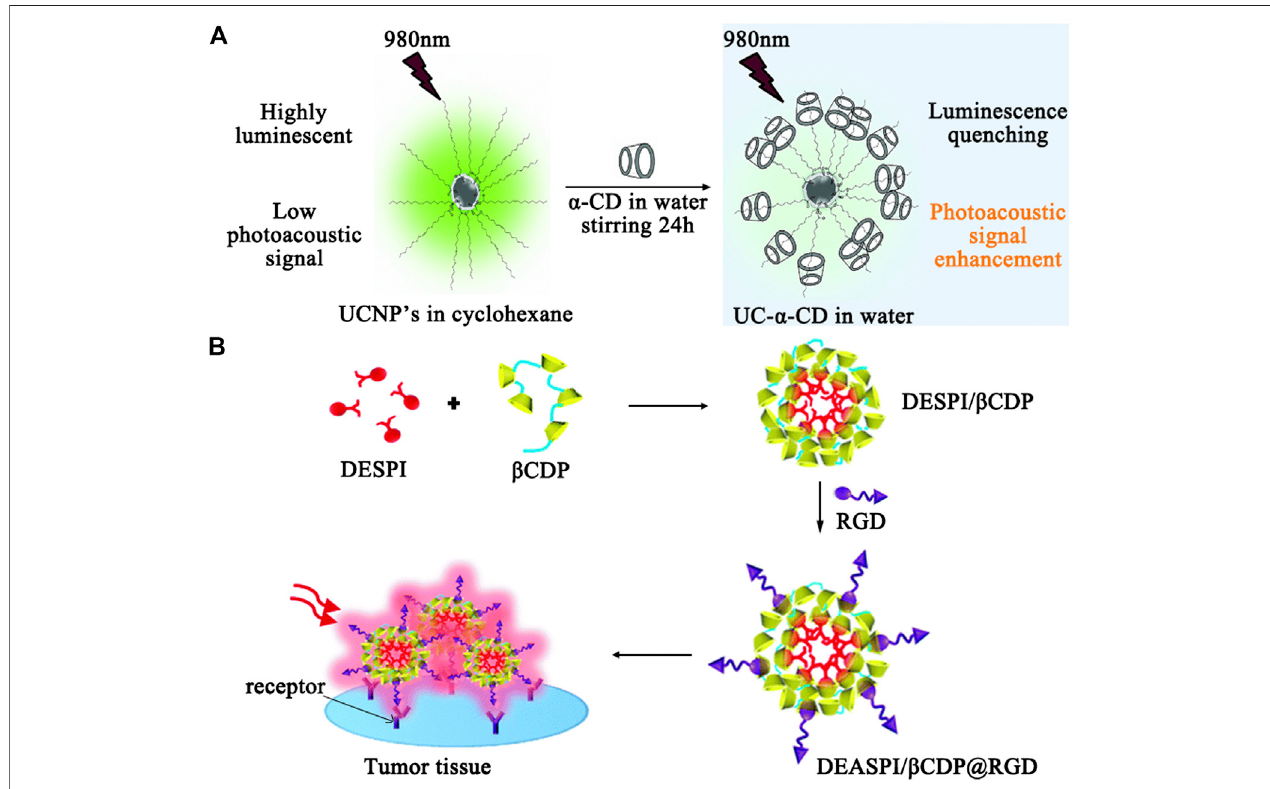
FIGURE 4 | (A) Illustration of luminescence quenching effect and subsequent photoacoustic signal enhancement from UC- α -CD in water. (B) Illustration of fabrication of the DEASPI/ β CDP nanomicelles and application in TPE tumor tissue imaging.